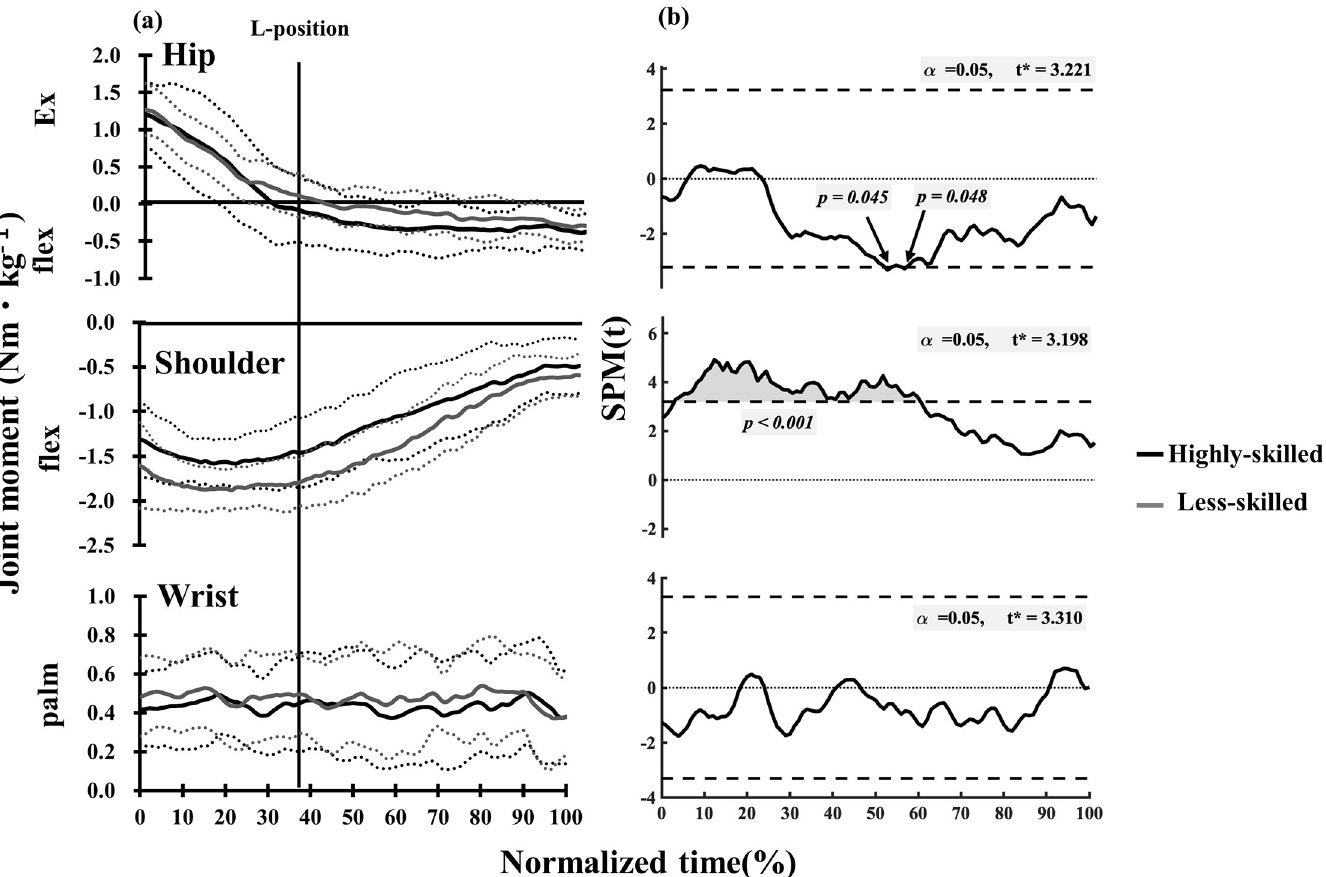
Fig 7. Changes in mean values of joint moments (a) and statistical parametric mapping (SPM) (b) between highly- skilled and less-skilled. Horizontal axis indicated normalized time of SAPH defined as 100% from Toe-off to Handstand. Dotted lines indicated mean ± one SD. Vertical line indicated the timing of Leg horizontal position. Associated SPM t-test results for differences between the curves in (b). The shaded area indicates suprathreshold clusters, which correspond to statistically significant differences between the curves at those nodes (percentage of normalized time).